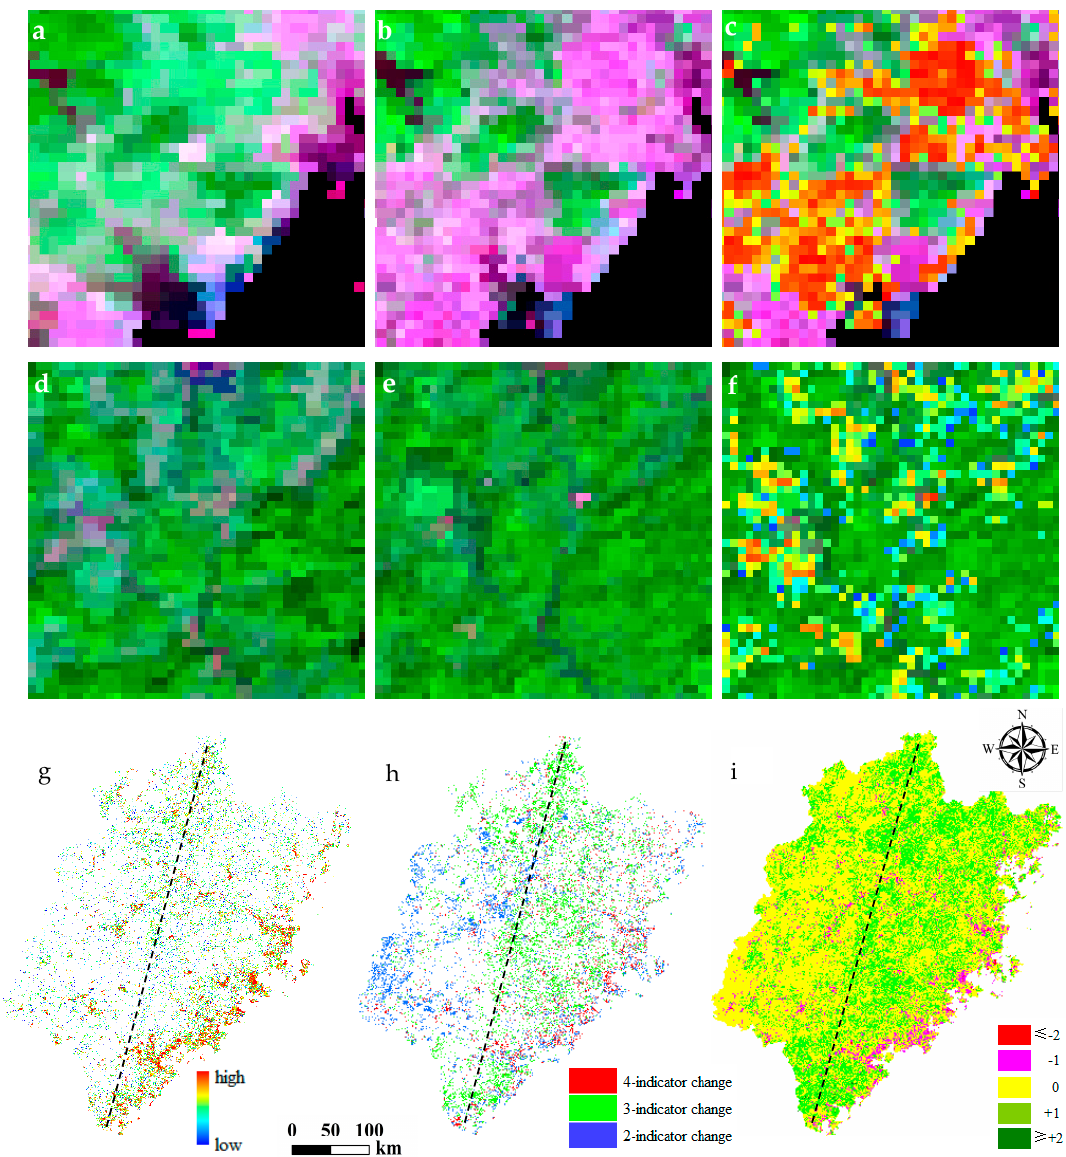
Figure 8. Ecological change maps in the 2002–2017 period. ( a – c ) Ecological change in a coastal area, ( d – f ) Ecological change in a forested area [( a , d ) original images of 2002, ( b , e ) original images of 2017, ( c , f ) change maps, see Figure 8g for legend], ( g ) Change magnitude map of four indicators, ( h ) Change intensity map of four indicators and ( i ) Change attribute map of RSEI. CVA was also calculated for each of the four RSEI’s indicators. The change images of the four indicators were then overlaid to form a change intensity map (Figure 8h), in which the pixel that underwent changes in all four indicators were represented by red colour, suggesting an intensive change in that pixel. The green- and blue-cloured pixels denote the areas that had changes in three and two indicators, respectively (for the clarity of the map, the patches with one-indicator change are not shown in the figure). The red patches, accounting for 1.6% of the change area (Table 5), occur mainly in the eastern coastal areas. This again suggests the intensive ecological changes in the coastal areas.